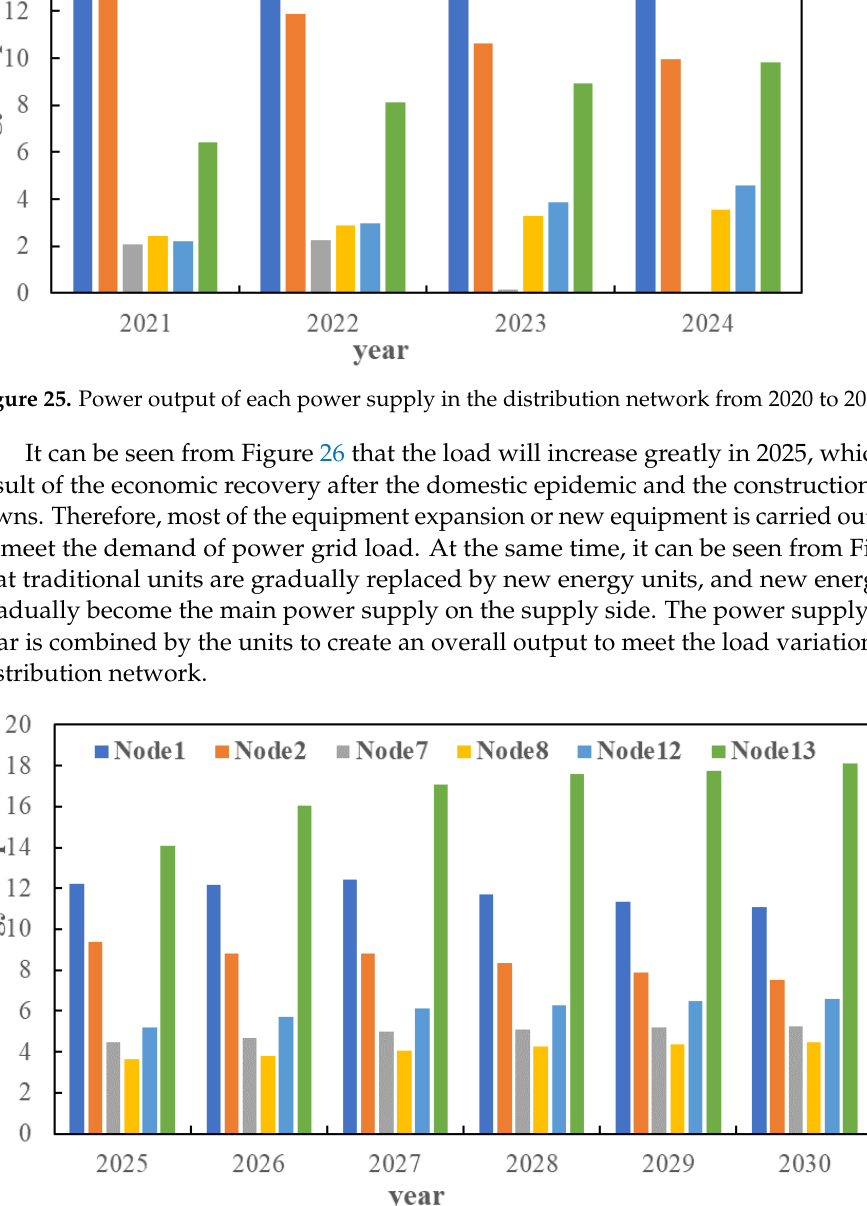
Figure 25. Power output of each power supply in the distribution network from 2020 to 2024.